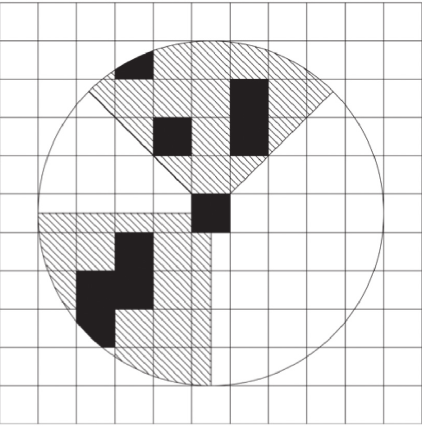
Figure 2: Moving direction and cell visual areas calculation